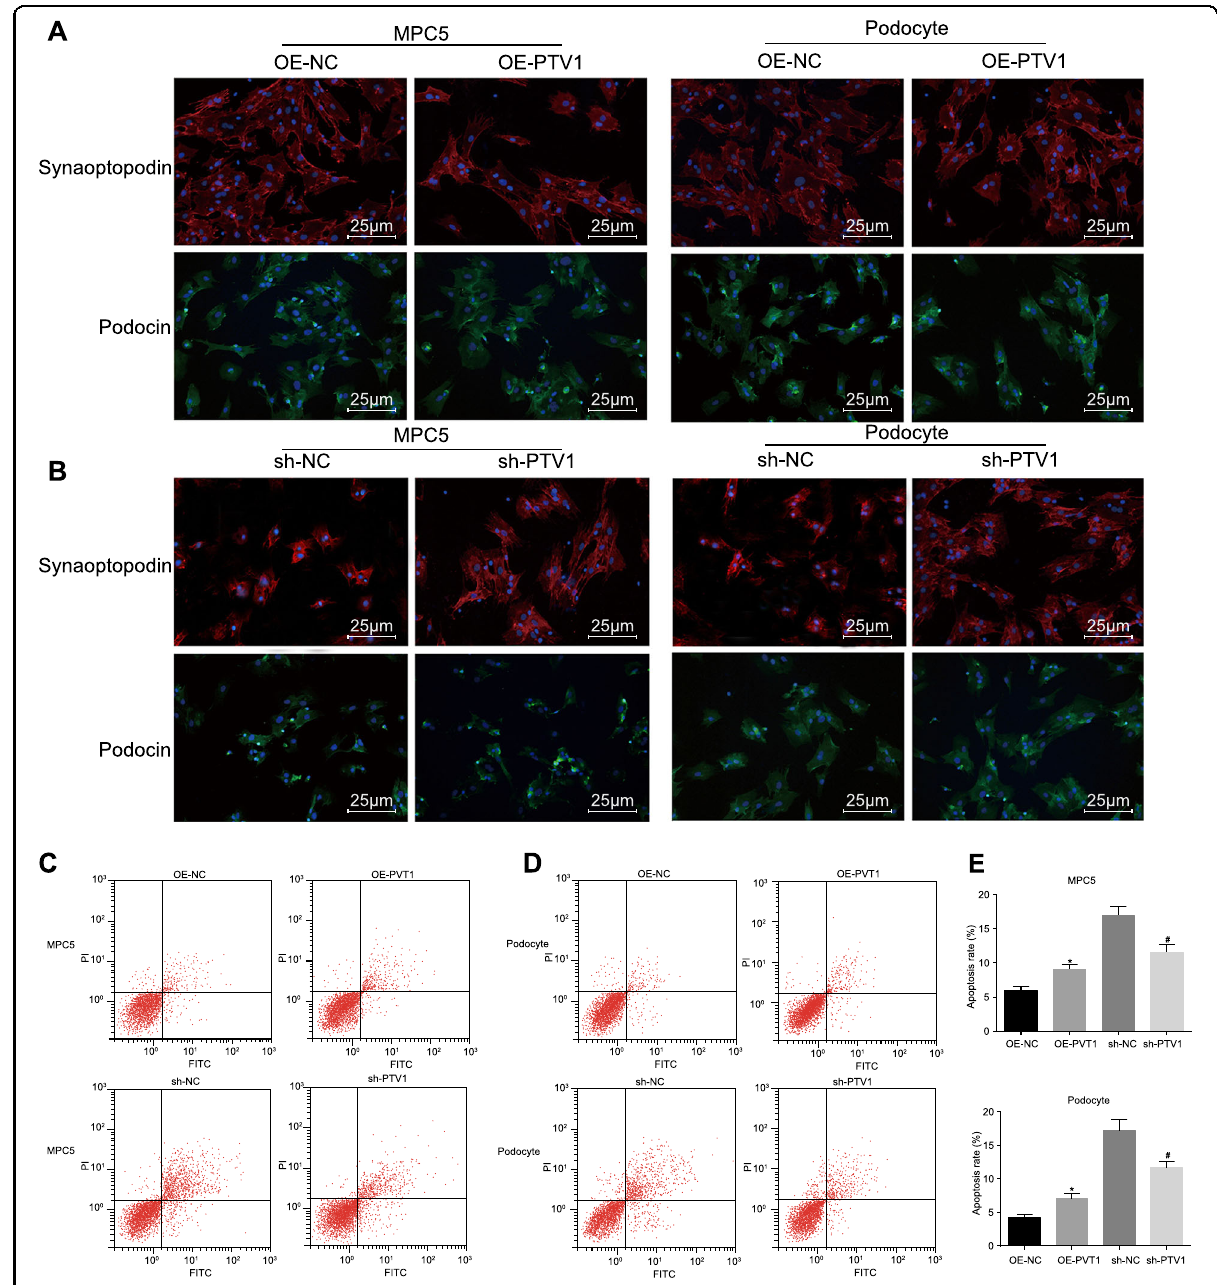
Fig. 2 The poor expression of lncRNA PVT1 inhibits the damage to and apoptosis of podocytes. a , b The cellular morphology of MPC5 and primary podocytes in NG and HG media (the original magni fi cation is ×400). c , d The apoptosis of MPC5 and primary podocytes in NG and HG media. e The apoptosis of MPC5 and primary podocytes in NG and HG media; * p < 0.05 vs. the OE-NC group; # p < 0.05 vs. the sh-NC group. The measurement data are expressed as the mean ± standard deviation, and the comparisons among multiple groups were analyzed by one-way analysis of variance (ANOVA). The experiment was repeated three times. MPC5, mouse podocyte clone 5; NG, normal glucose; HG, high glucose; OE, overexpressed; NC, negative control; lncRNA, long noncoding RNA; PVT1, plasmacytoma variant translocation